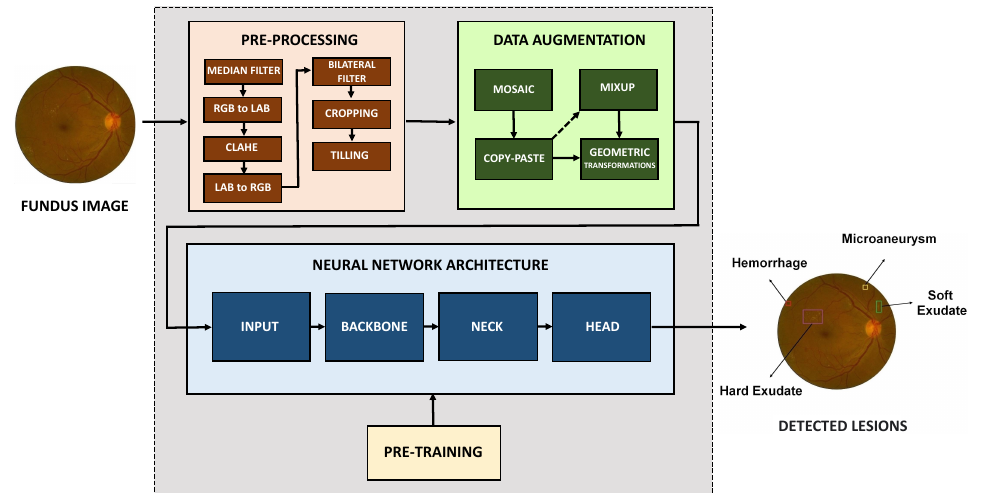
Figure 1. Block diagram of the proposed approach. First, the images are passed to the Pre-processing block for noise filtering, contrast improvement, partial elimination of the black background of the images, and creation of tiles . Then, the pre-processed images are transferred to the Data Augmentation block, where sub-images are artificially created that will be used in the neural network input layer for training the proposed approach, which will be carried out after a pre-stage step training the network with the weights fitted to the Common Objects in Context (COCO)